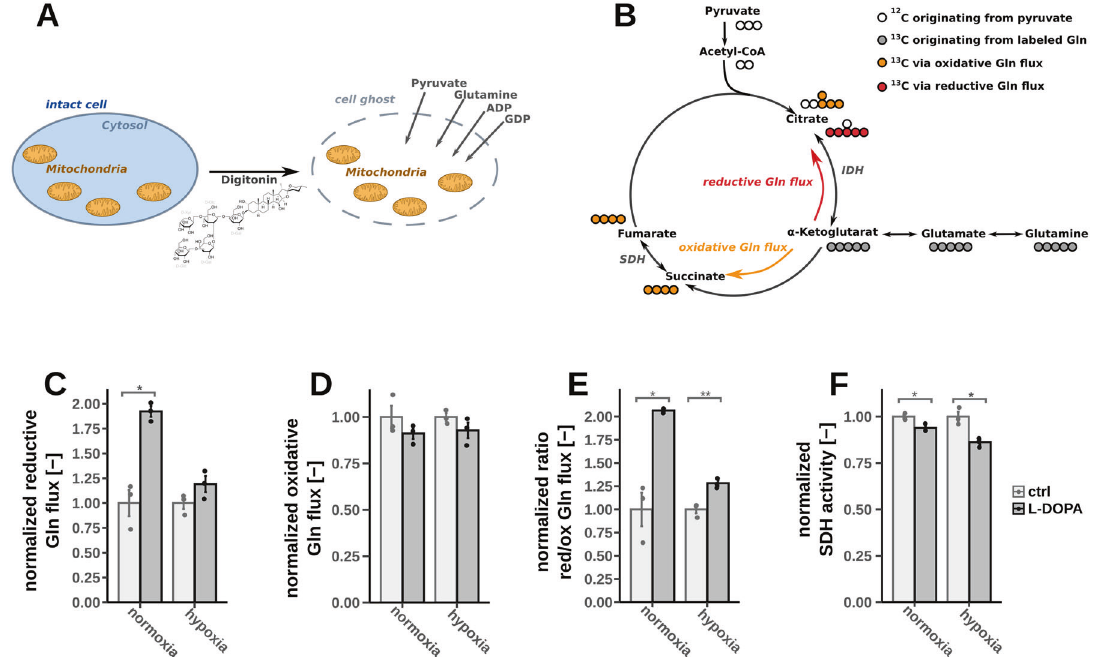
Fig. 4 Multiple assays under after 2 h of L -DOPA treatment on fully differentiated LUHMES cells, signi fi cance level were calculated using Welch ’ s t -test (* p -value < 0.05, ** p -value < 0.01, *** p -value < 0.001). A Intracellular ATP levels ( n = 10). B Combined NAD and NADH level intracellular (normoxia: n = 4, hypoxia: n = 5). C Combined NADP and NADPH level intracellular ( n = 6). D MMP after supplementation of NAD under hypoxic conditions ( n =